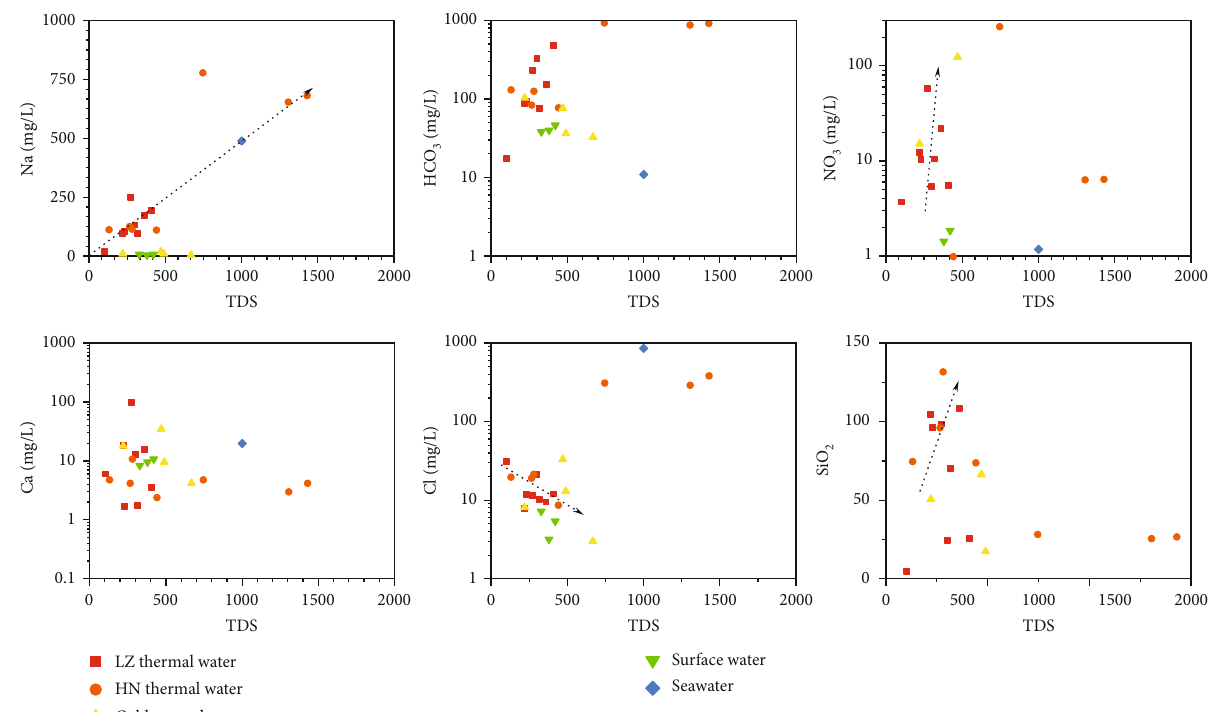
Figure 4: Relationships between various ions (NO